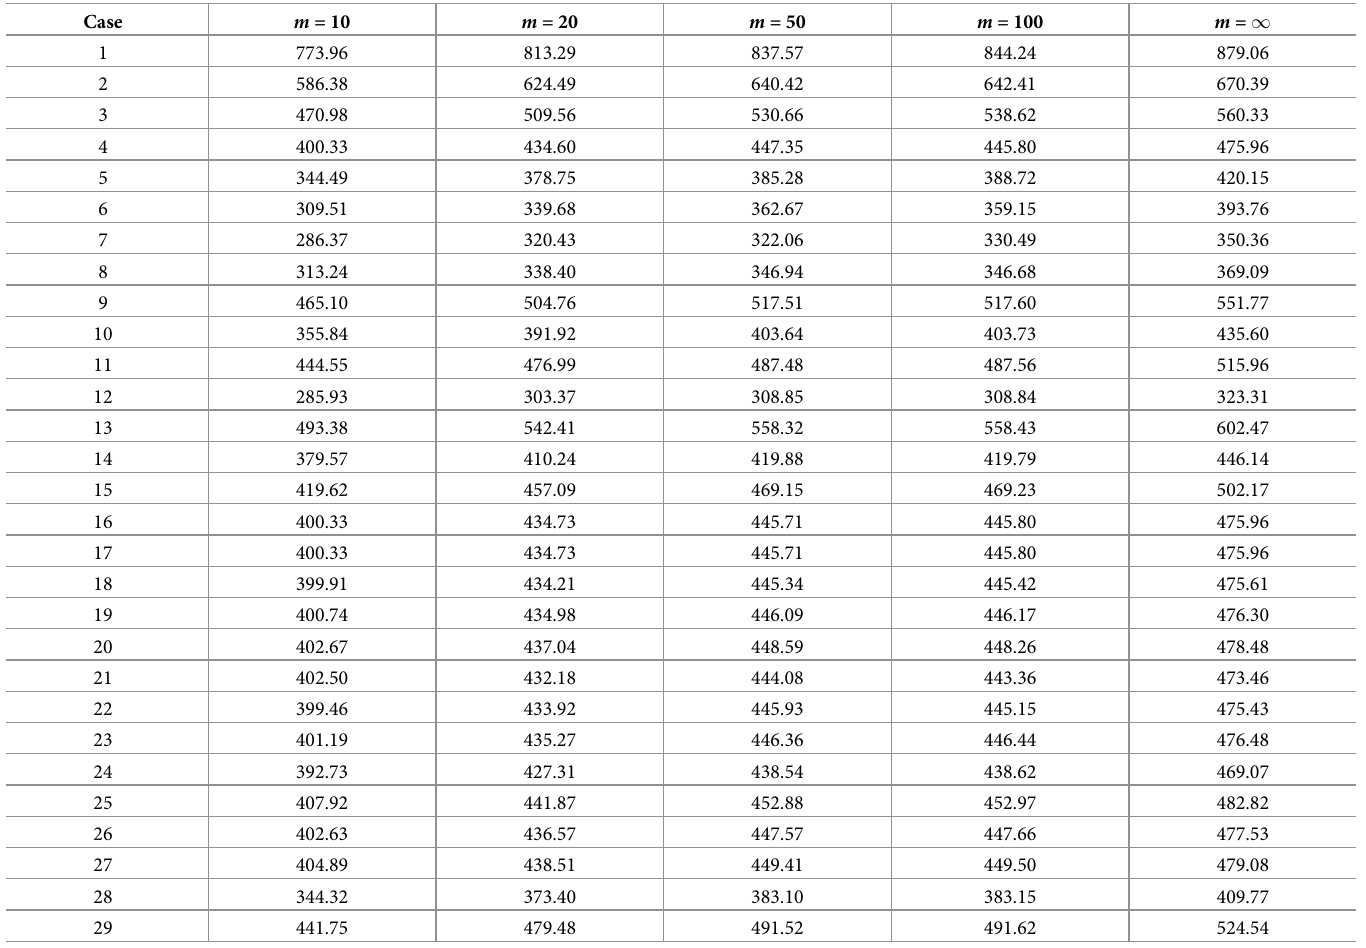
Table 5. Expected cost of the synthetic np chart with estimated process parameter corresponding to the optimal chart parameters of the estimated process parame- ter